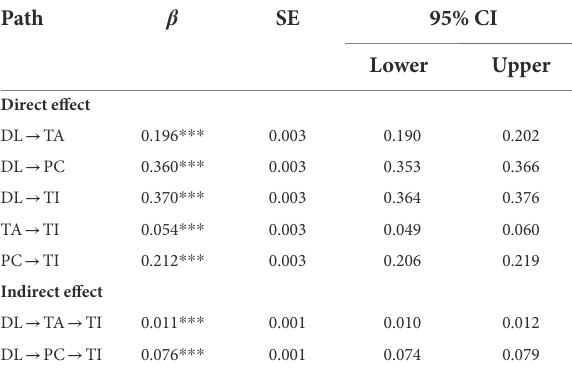
TABLE 3 Structural equation modelling results with standardized coefficients.